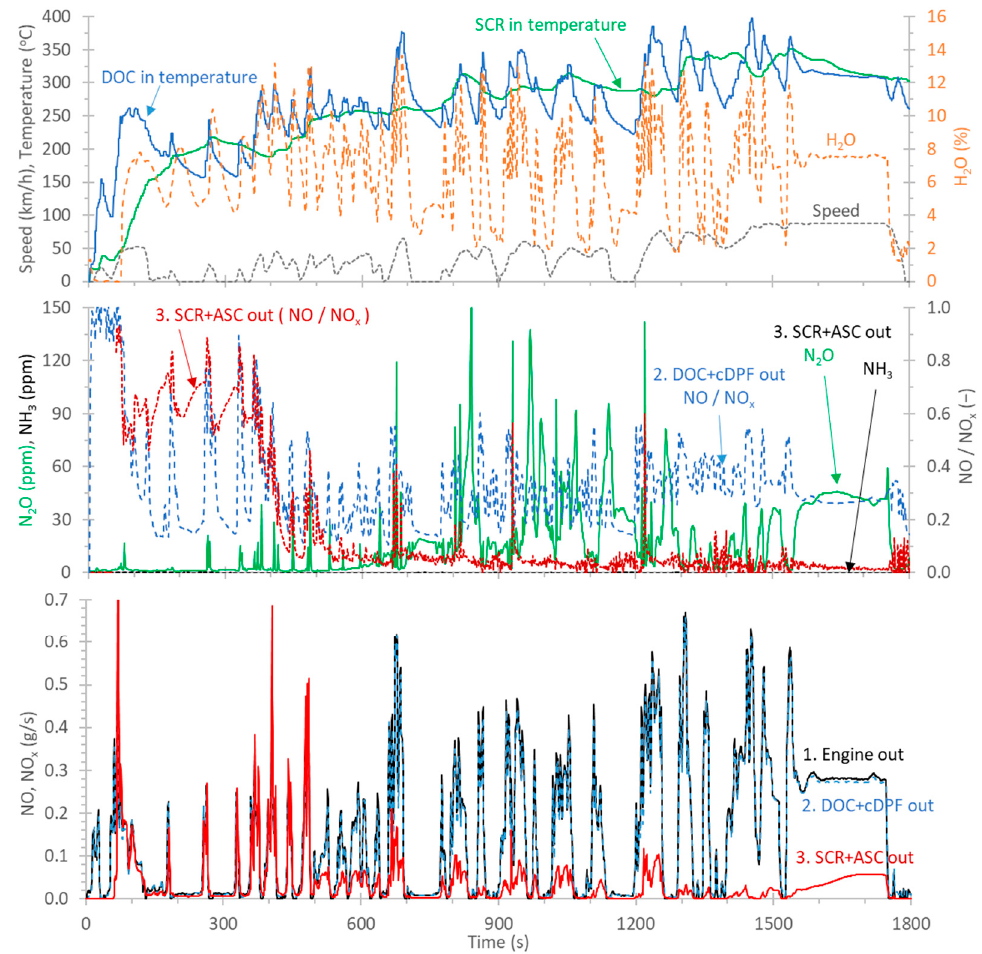
Figure 1. Cold start world harmonized vehicle cycle (WHVC) at 23 °C. The upper panel plots the speed profile, the temperatures at the inlet of the DOC and the SCR, and the H 2 O concentration in the exhaust gas. The middle panel plots NH 3 and N 2 O at position 3, and the NO/NO x ratios for positions 2 and 3. The lower panel plots the NO x emissions (continuous lines) at the three sampling locations. ASC = ammonia slip catalyst; DOC = Diesel oxidation catalyst; cDPF = catalyzed Diesel particulate filter; SCR = selective catalytic reduction.